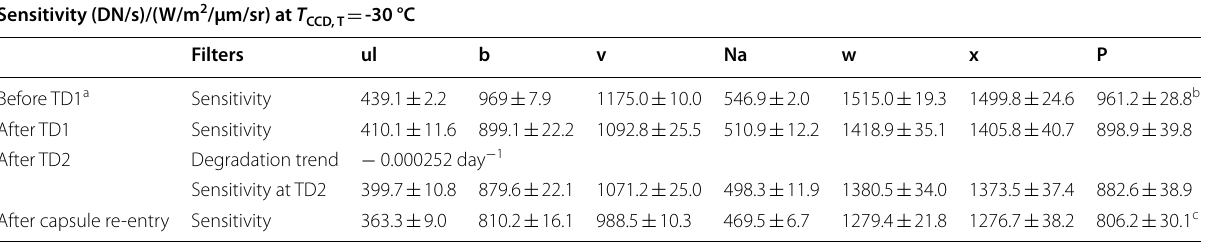
a Tatsumi et al. (2019). b Value based on lunar observations. c Value from observing the same star at different times